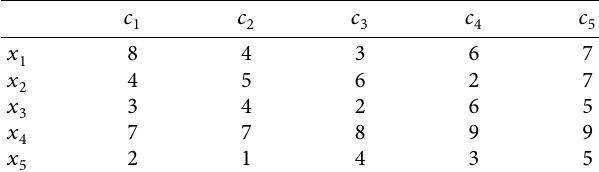
Table 1: Accurate number rating.